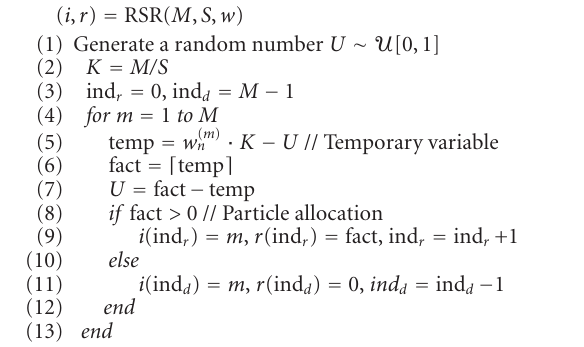
Pseudocode 3: Modified residual systematic resampling (RSR) al-